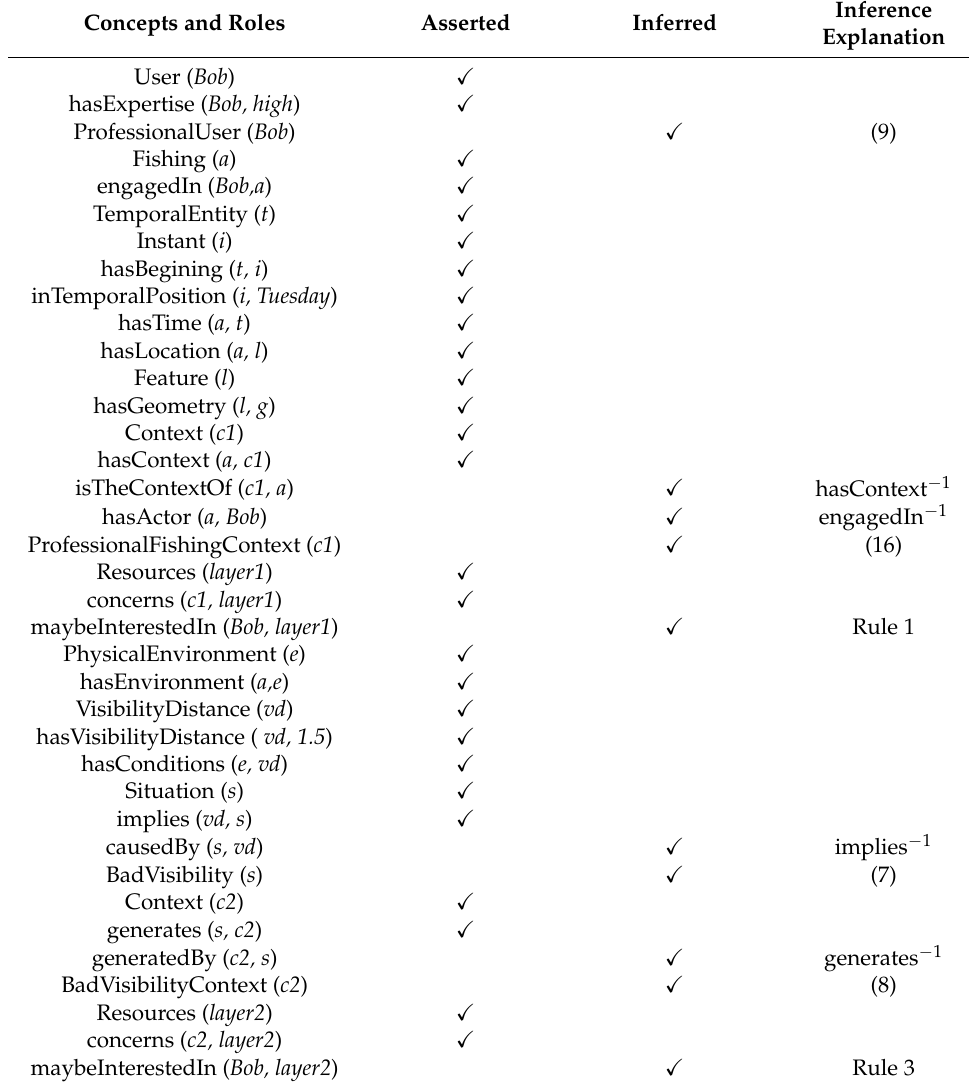
Table 5. Model instantiation by assertion and reasoning. Last column indicates the origin of the